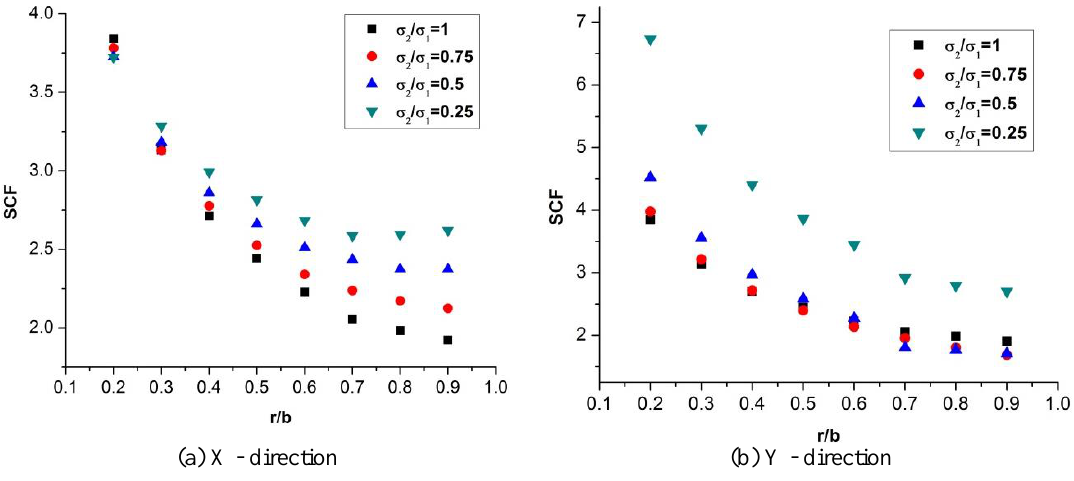
Figure 7. Variation of SCF with loading ratio for b/a = 1